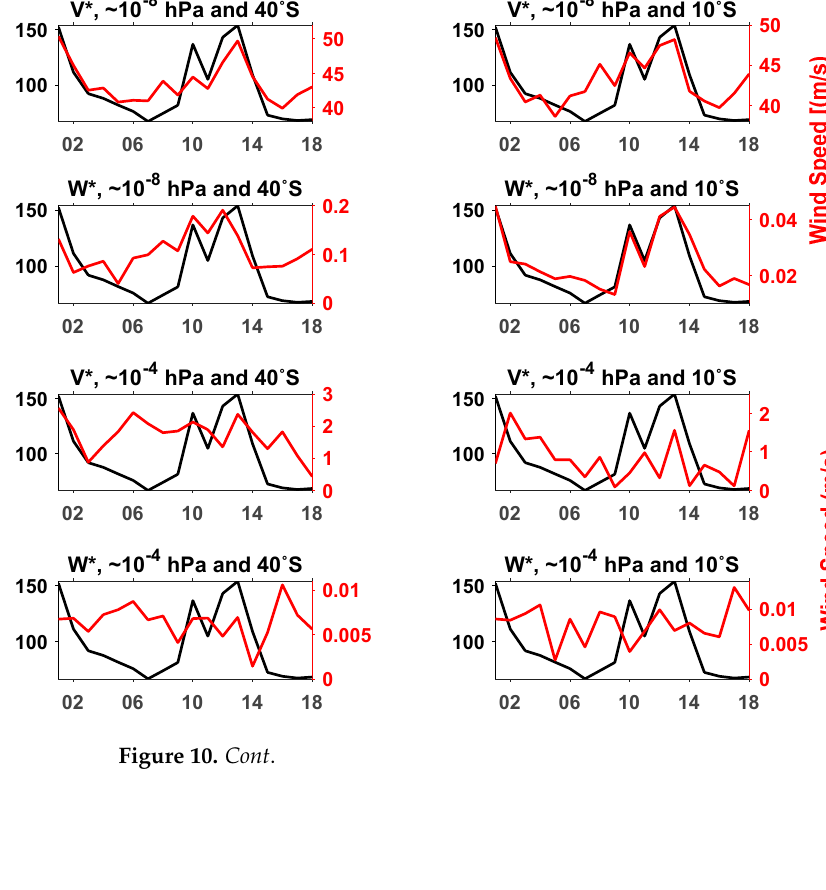
Figure 9. Time series of the meridional and vertical components of atmospheric circulation at a specified altitude (~10 − 8 hPa, first two rows; ~10 − 4 hPa, middle two rows; ~10 − 2 hPa, last two rows) and latitude (~70 ◦ S, left column; ~40 ◦ S, middle column; ~10 ◦ S, right column) and the F10.7 solar index in June from 2002 to 2019. The black and red lines indicate the F10.7 solar index and the corresponding component of atmospheric circulation, respectively.